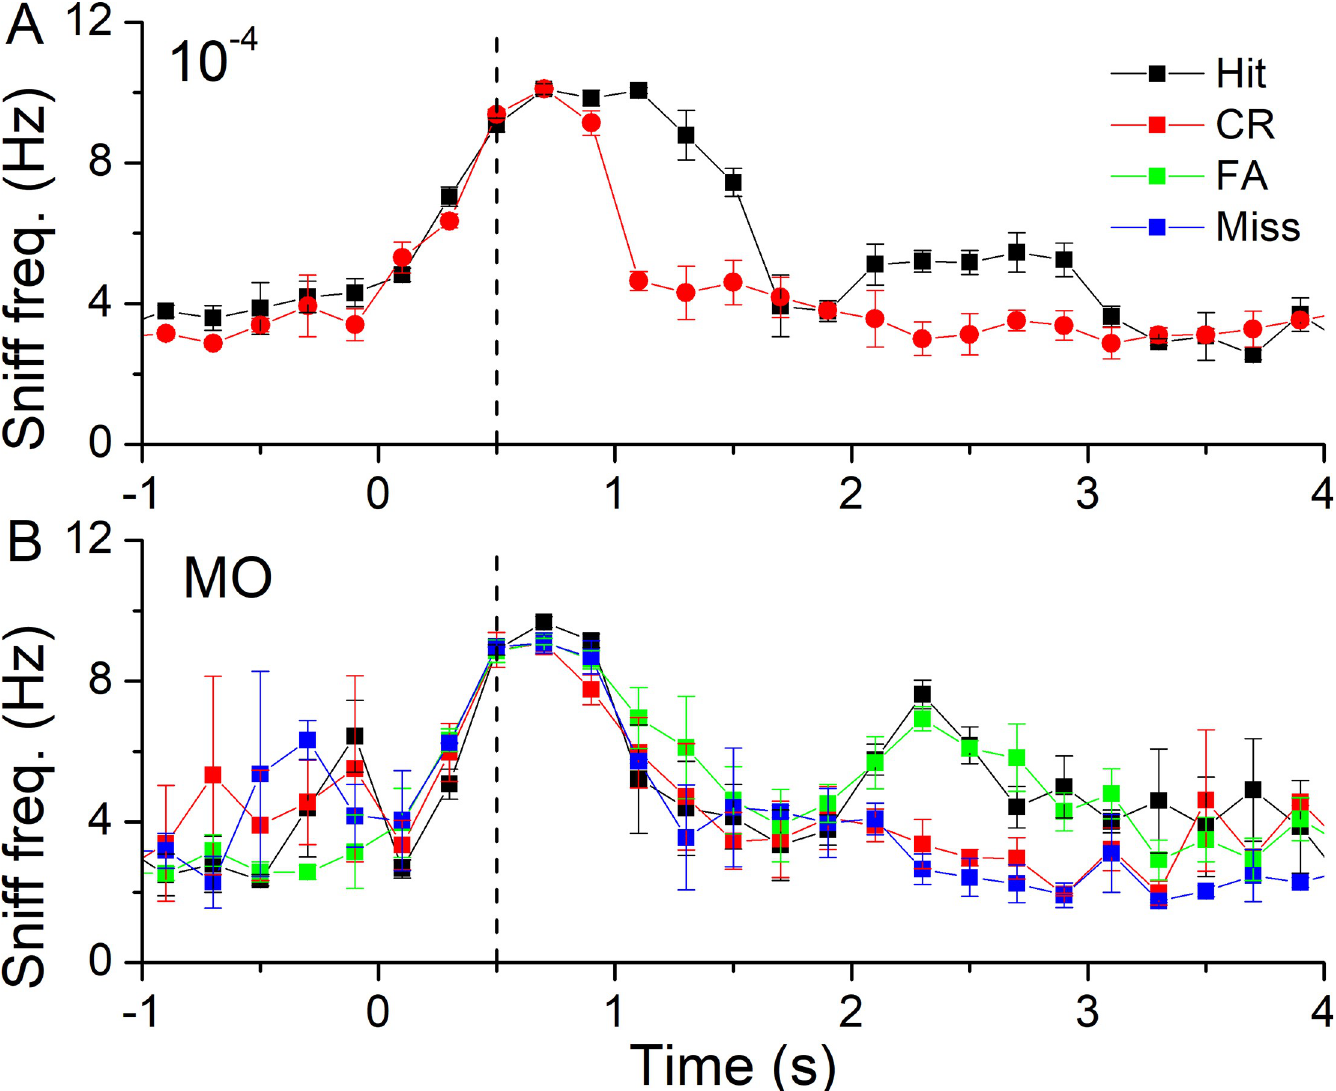
Fig 3. Sniff patterns during odorant sampling. The sniff frequency of a mouse when tested with ( A ) a 10 − 4 propanol concentration or ( B ) when the S+ odorant was mineral oil (MO). Sniff frequencies were binned in 0.2 s bins according to their behavioral outcome and averaged (mean ± SEM) across trials of one block of 20 trials. Vertical dashed line indicates odorant